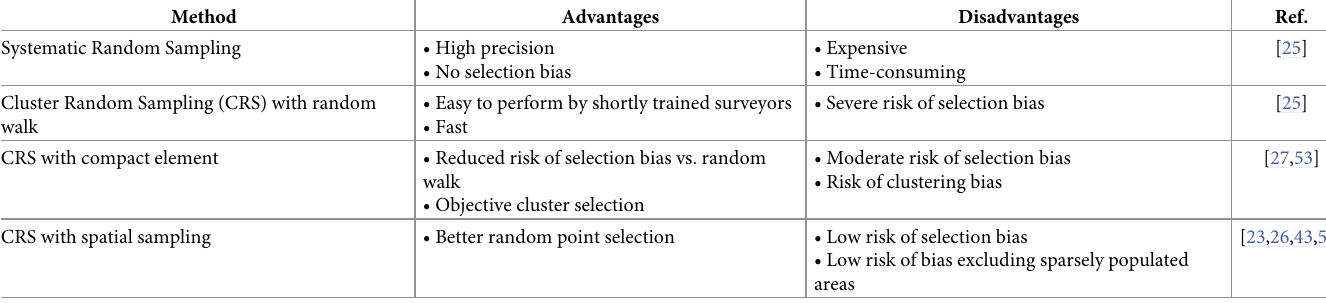
Table 1. Comparison between common sampling